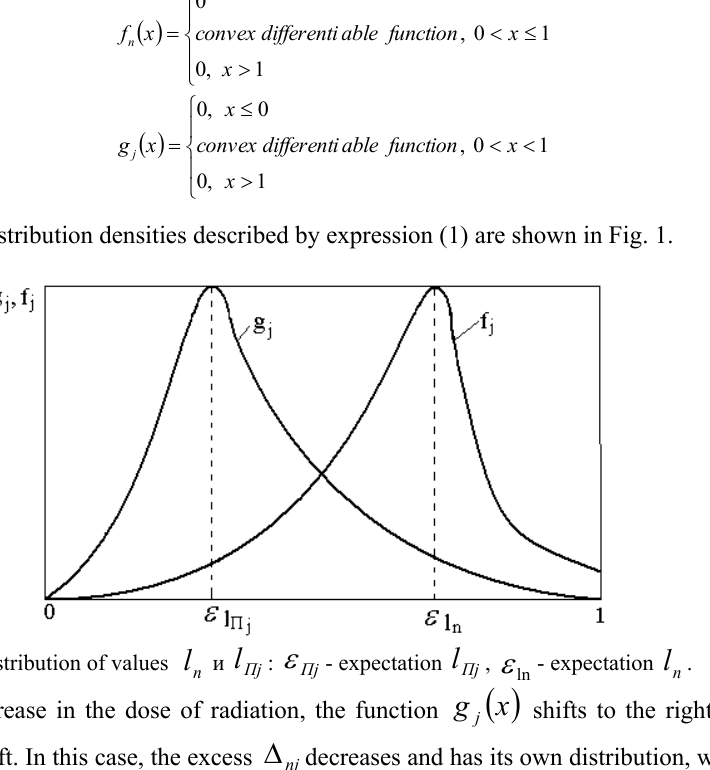
l ,  - expectation Пj ln   xg shifts to the right j